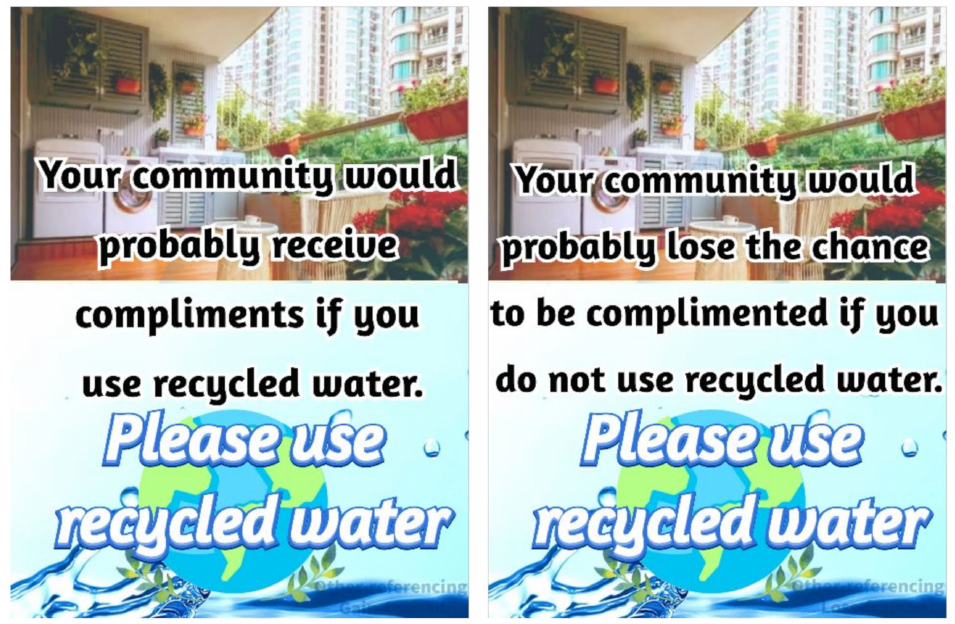
Figure 2. Examples of stimulus materials. (Note: The text in the posters that we showed to our participants was in Chinese. The text in Figure 2 is a direct translation of the Chinese text into